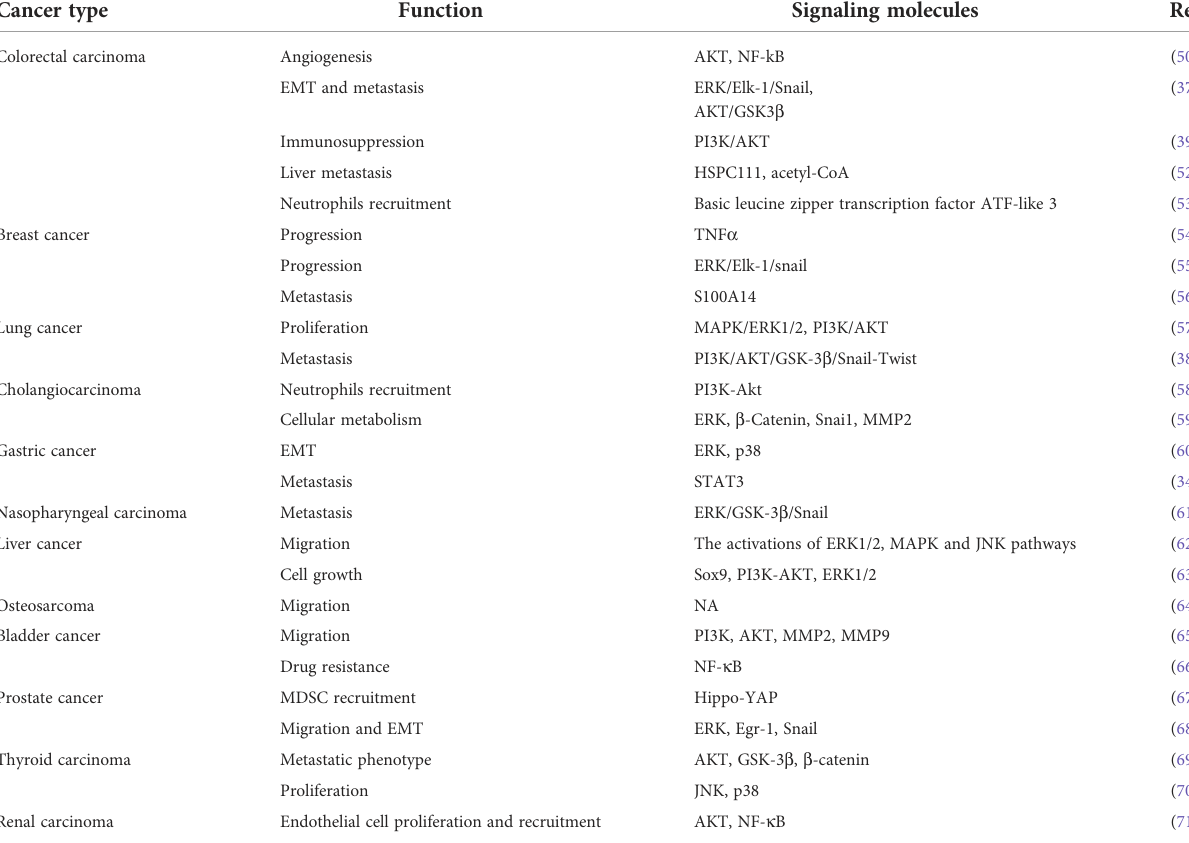
TABLE 2 A variety of signaling molecules and pathways are involved in CXCL5 to promote cancer